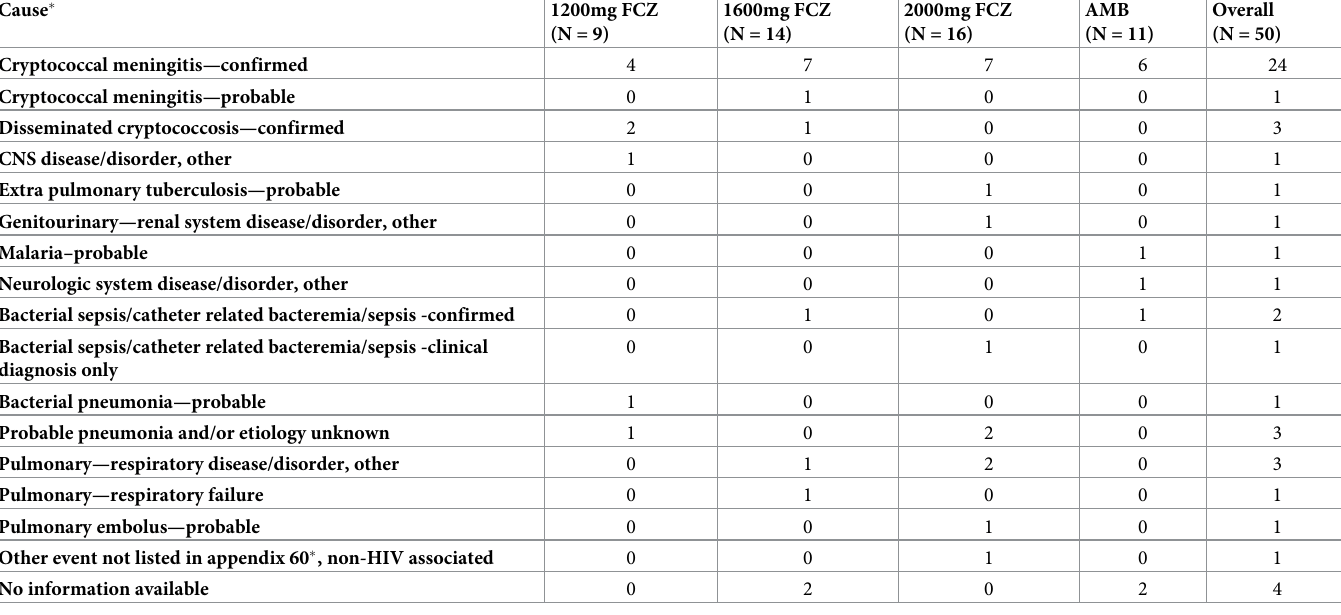
Table 6. Causes of